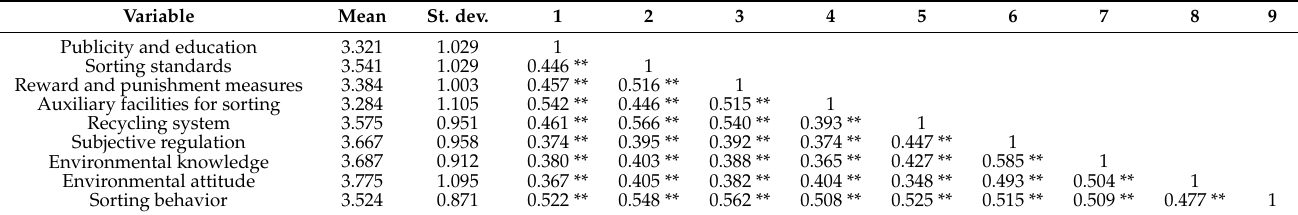
Table 17. Correlation analysis